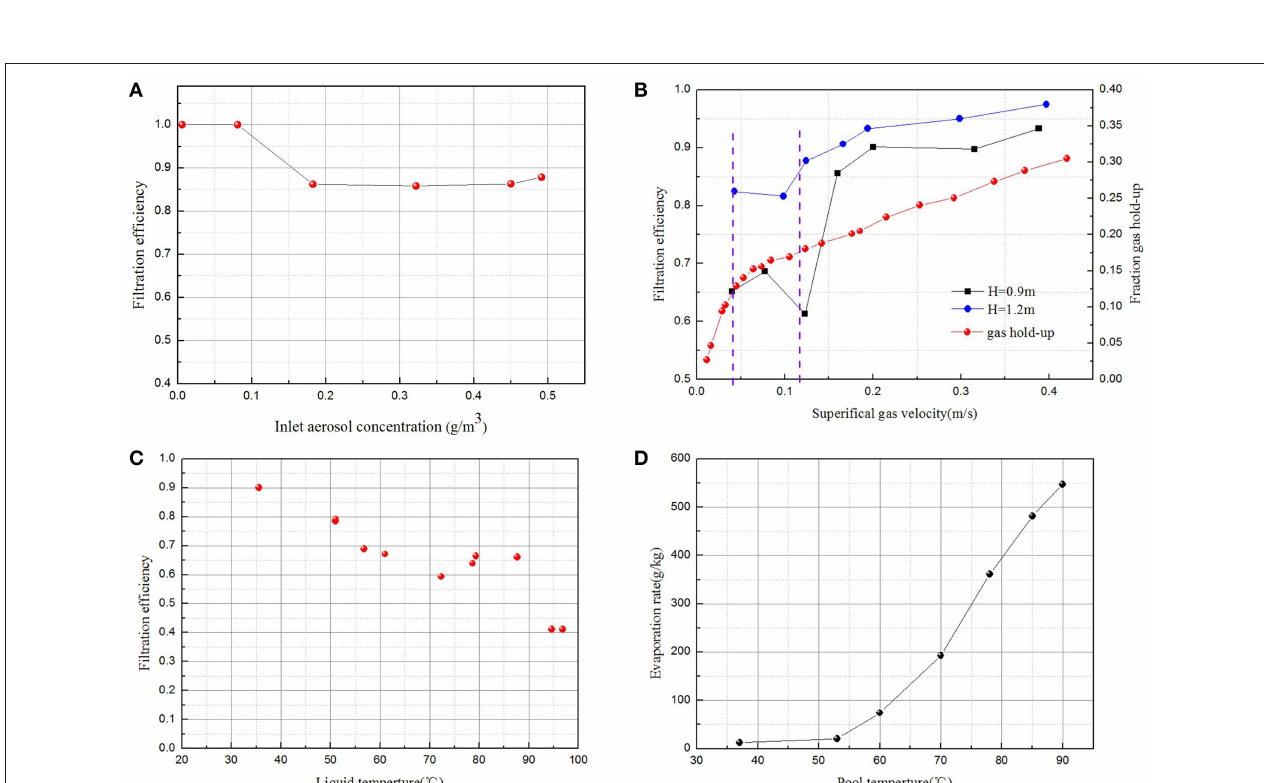
FIGURE 3 | Influence of operation parameter on filtration efficiency (A) inlet aerosol concentration; (B) gas flow rate; (C) pool temperature; and (D) influence of pool temperature on evaporation rate.